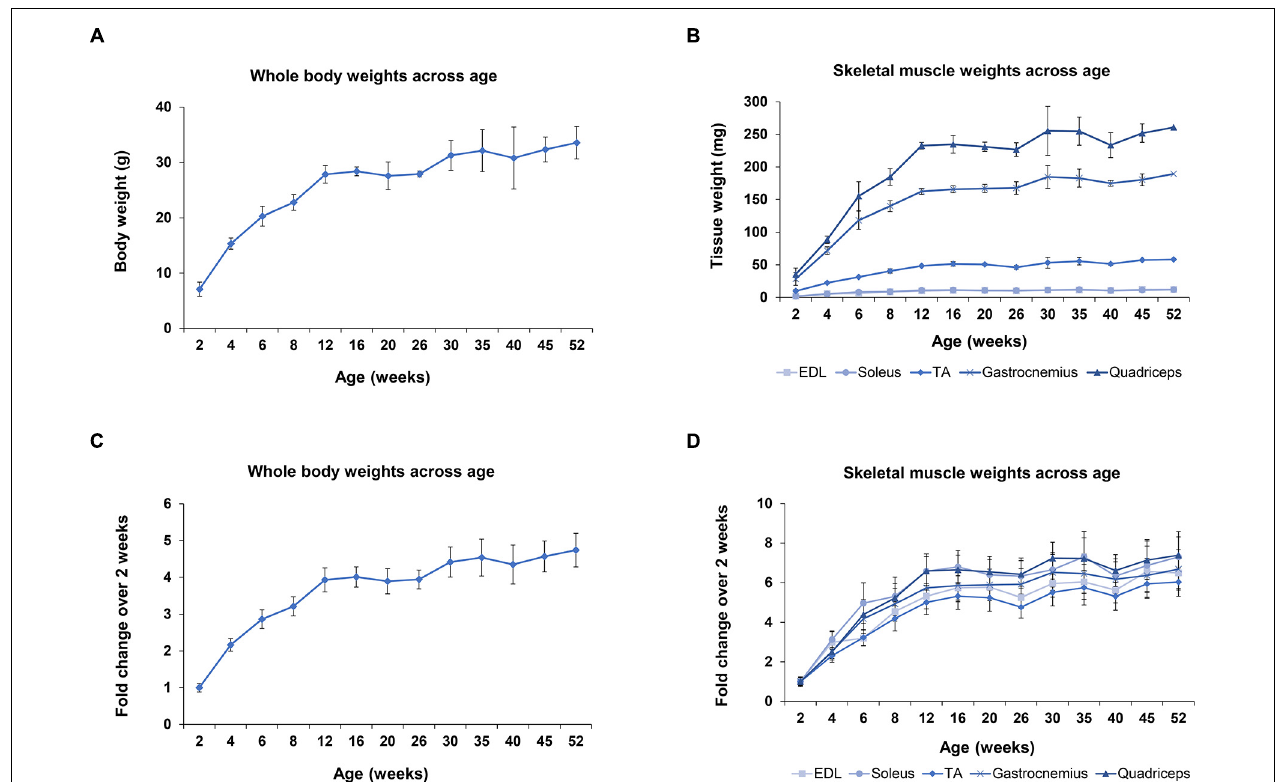
FIGURE 5 | Whole body and skeletal muscle weights during the first year of life in wild-type mice. Whole body and skeletal muscle tissues weight were recorded for all mice under investigation ( n = 3). (A) Body weights of mice increased rapidly until 12 weeks of age, which corresponds to the period that mice switch from adolescence to adulthood. (B) EDL and soleus muscles are the lightest tissues examined in this project with similar weights across all ages. TA muscle is approximately 5 times heavier than EDL and soleus. Gastrocnemius and quadriceps muscles are the heaviest tissues, weighing 18–20 times more than the smaller tissues, EDL and soleus, for all the examined ages. (C) Fold change of mice body weights compared to the 2-week weight demonstrated a fourfold increase until the age of 12 weeks and then reached a plateau. (D) Fold change of the five skeletal muscle weights compared to the 2-week time-point showed the same trendline as the body weight profile in C, but with larger fold changes. All tissues reached a plateau phase at 12 weeks and displayed a five to sevenfold increase. Data on graphs illustrate the mean values ±